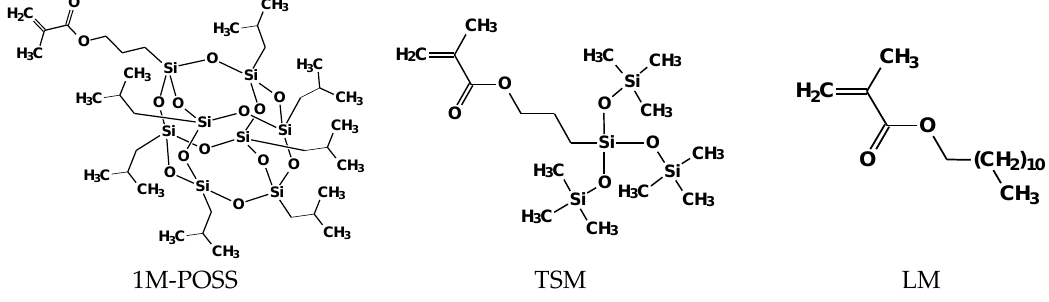
Figure 1. Structures of the monomers used.